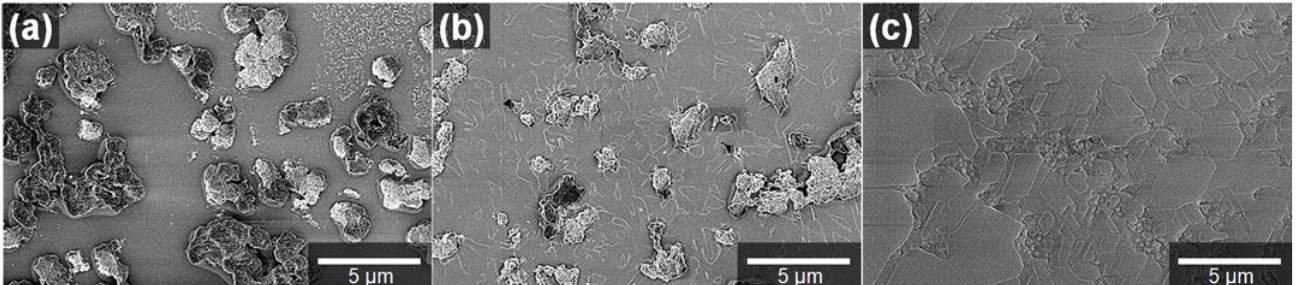
Figure 4. Scanning electron microscope (SEM) images of the surfaces of the BeO thin films with a 1:1 ratio of CA/BeSO 4 created by the two-step spin-coating method following sintering at tempera- tures of ( a ) 1100 °C, ( b ) 1300 °C, and ( c ) 1500